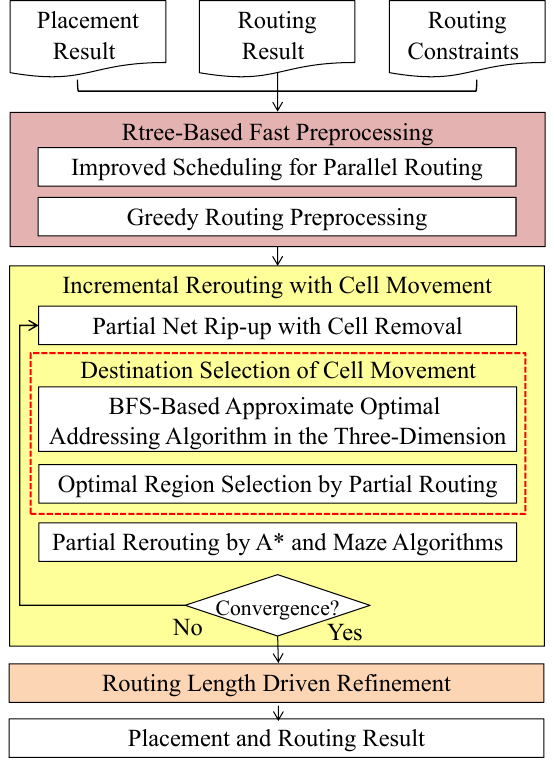
Figure 1. Our proposed